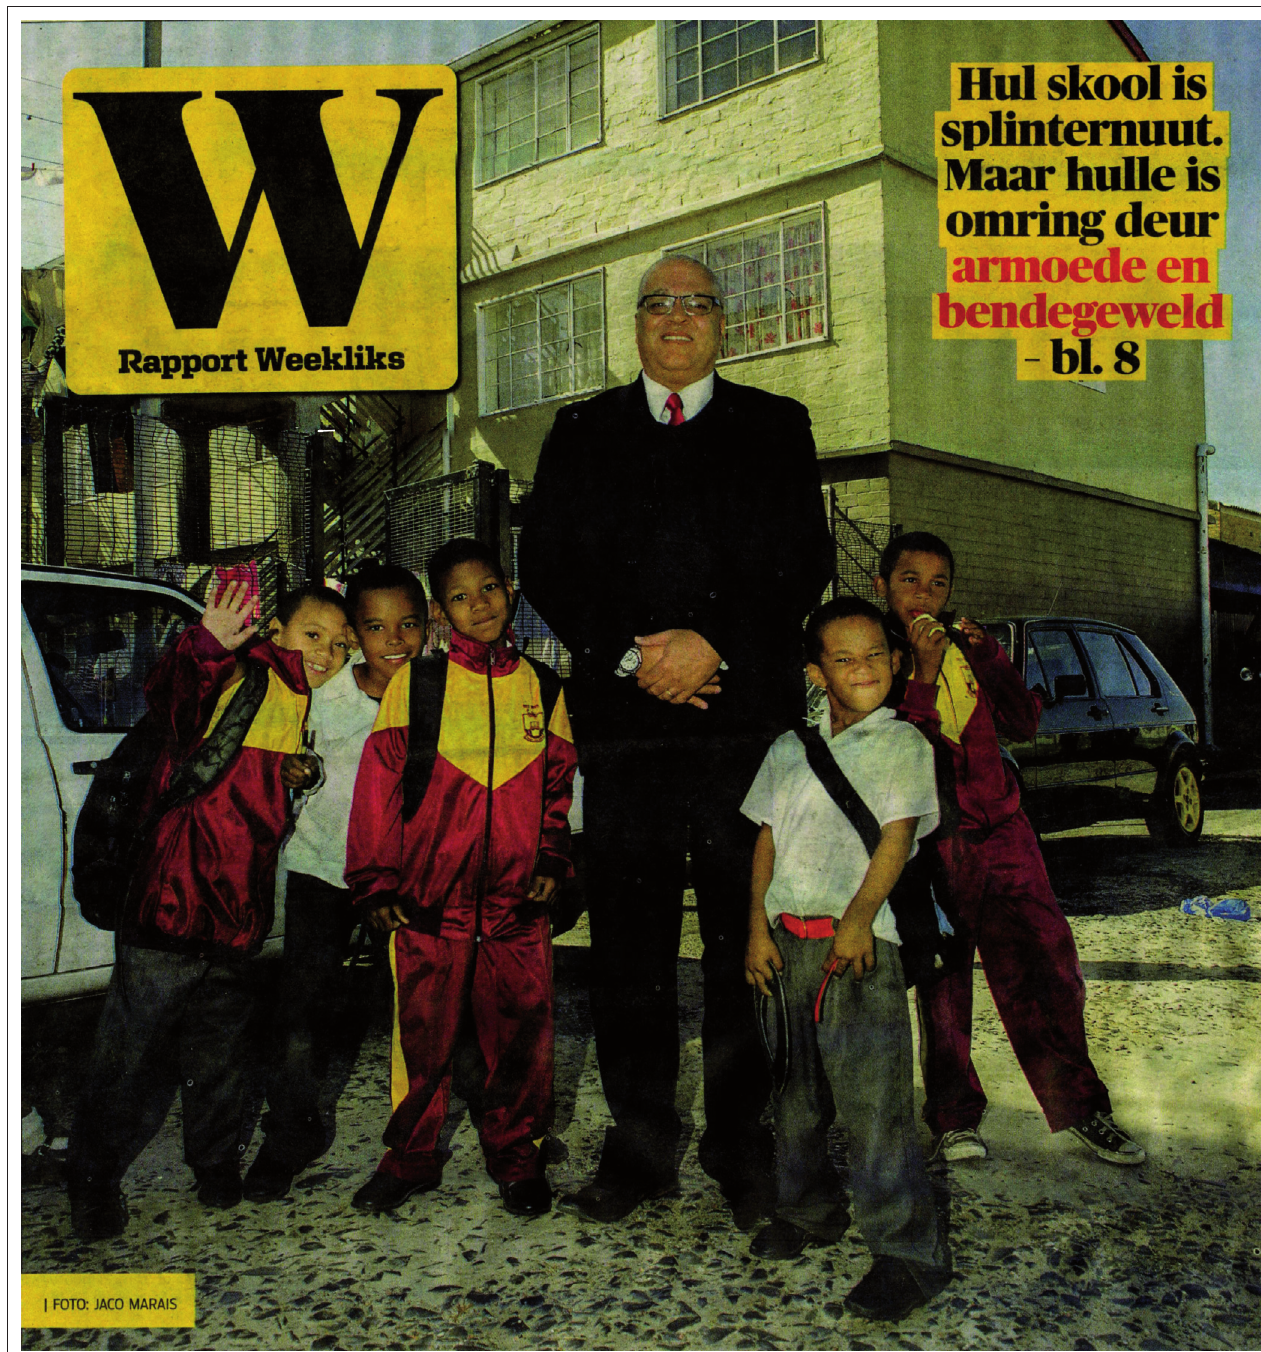
FIGUUR 10: Mnr. Everett Poole, skoolhoof van Red River Primêre Skool, saam met leerders voor een van die nuwe skoolgeboue wat teen R60 miljoen opgerig